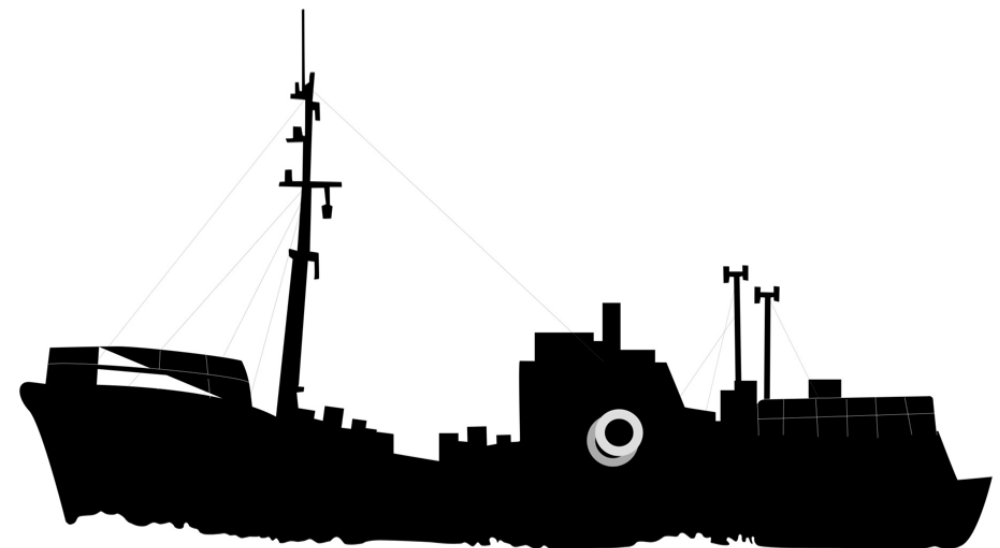
Figure 3. Simplified sketch of a typical fishing trawler